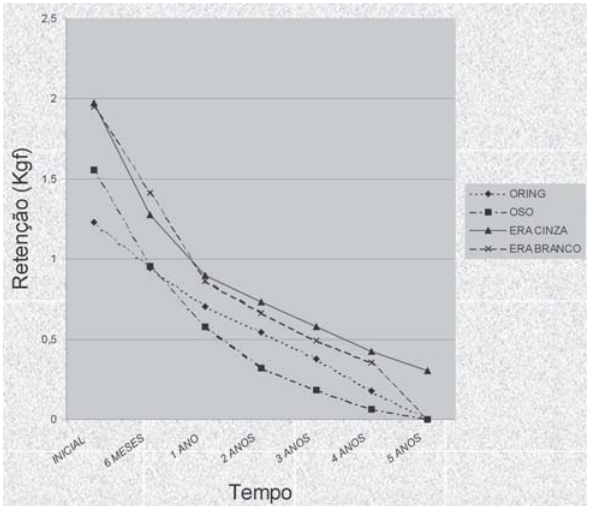
FIGURA 1- Resultados médios da perda de retenção dos conjuntos testados nos períodos de tempo inicial a 5 anos de uso